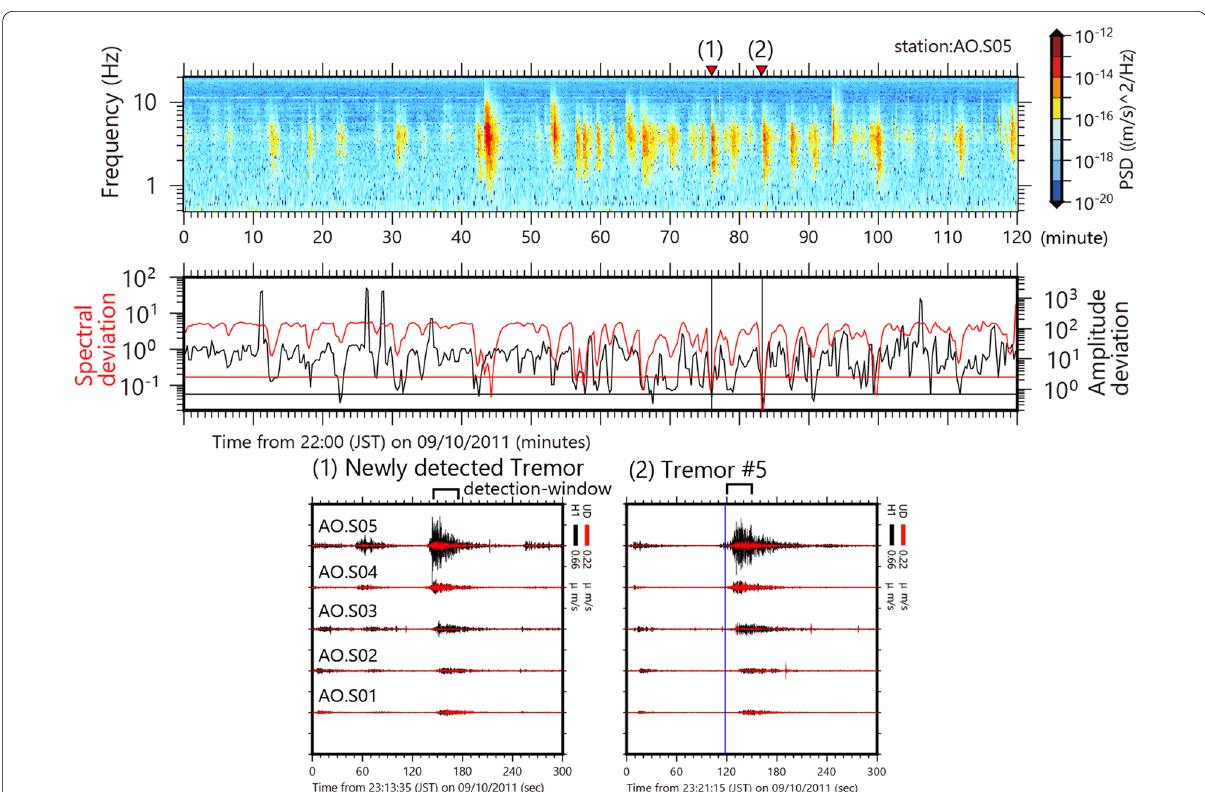
Fig. 6 Two-hour spectrogram of the horizontal component at AO.S05 (top), with temporal variation of amplitude and spectral deviations (middle), and seismograms of two identified tremors, (1) and (2), (bottom). Horizontal red and black lines in the middle panel show the detection threshold of spectral and amplitude deviations , respectively. Vertical and horizontal component records are indicated by red and black traces, respectively, in the bottom